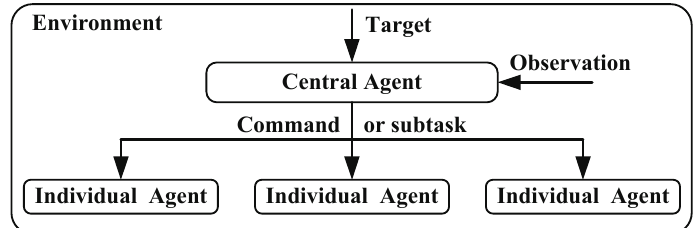
Figure 1. Hierarchical multi-agent-based coordination in interception tasks.